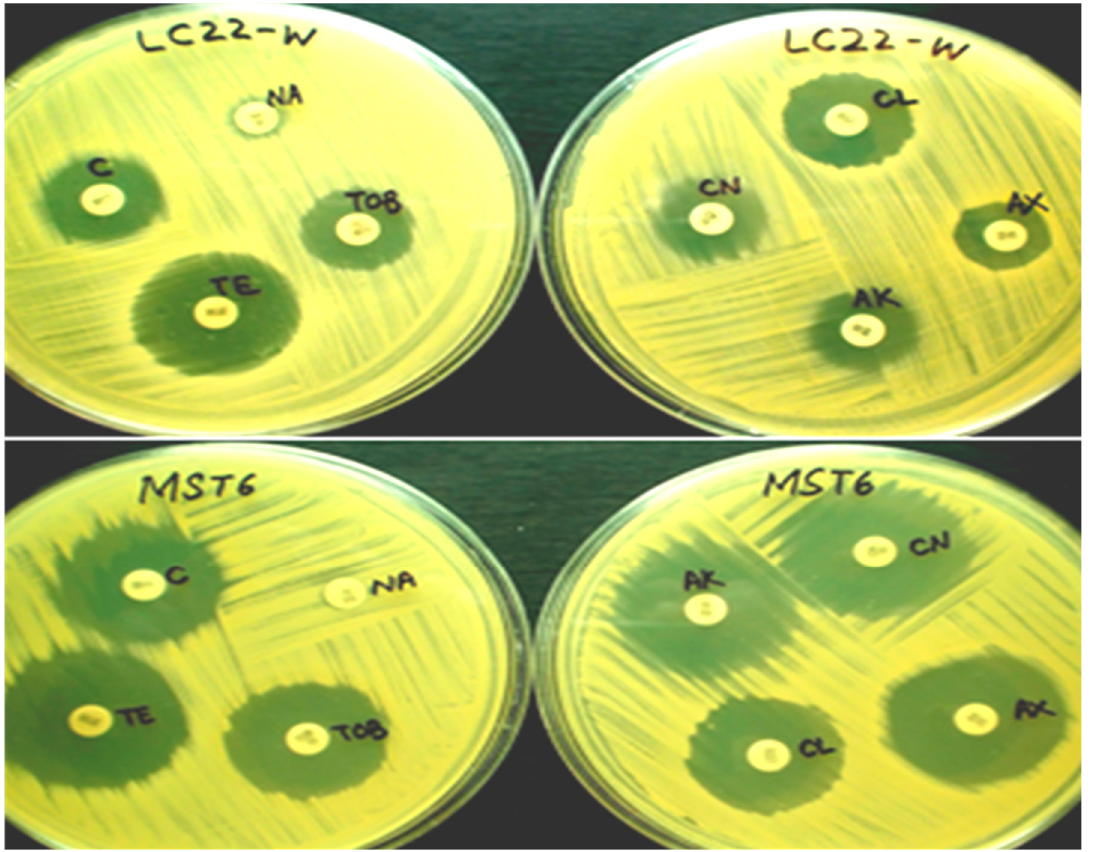
Figure 2. Antibiotic susceptibility pattern of purified strains of B. cereus LCw ‐ 22 and A.